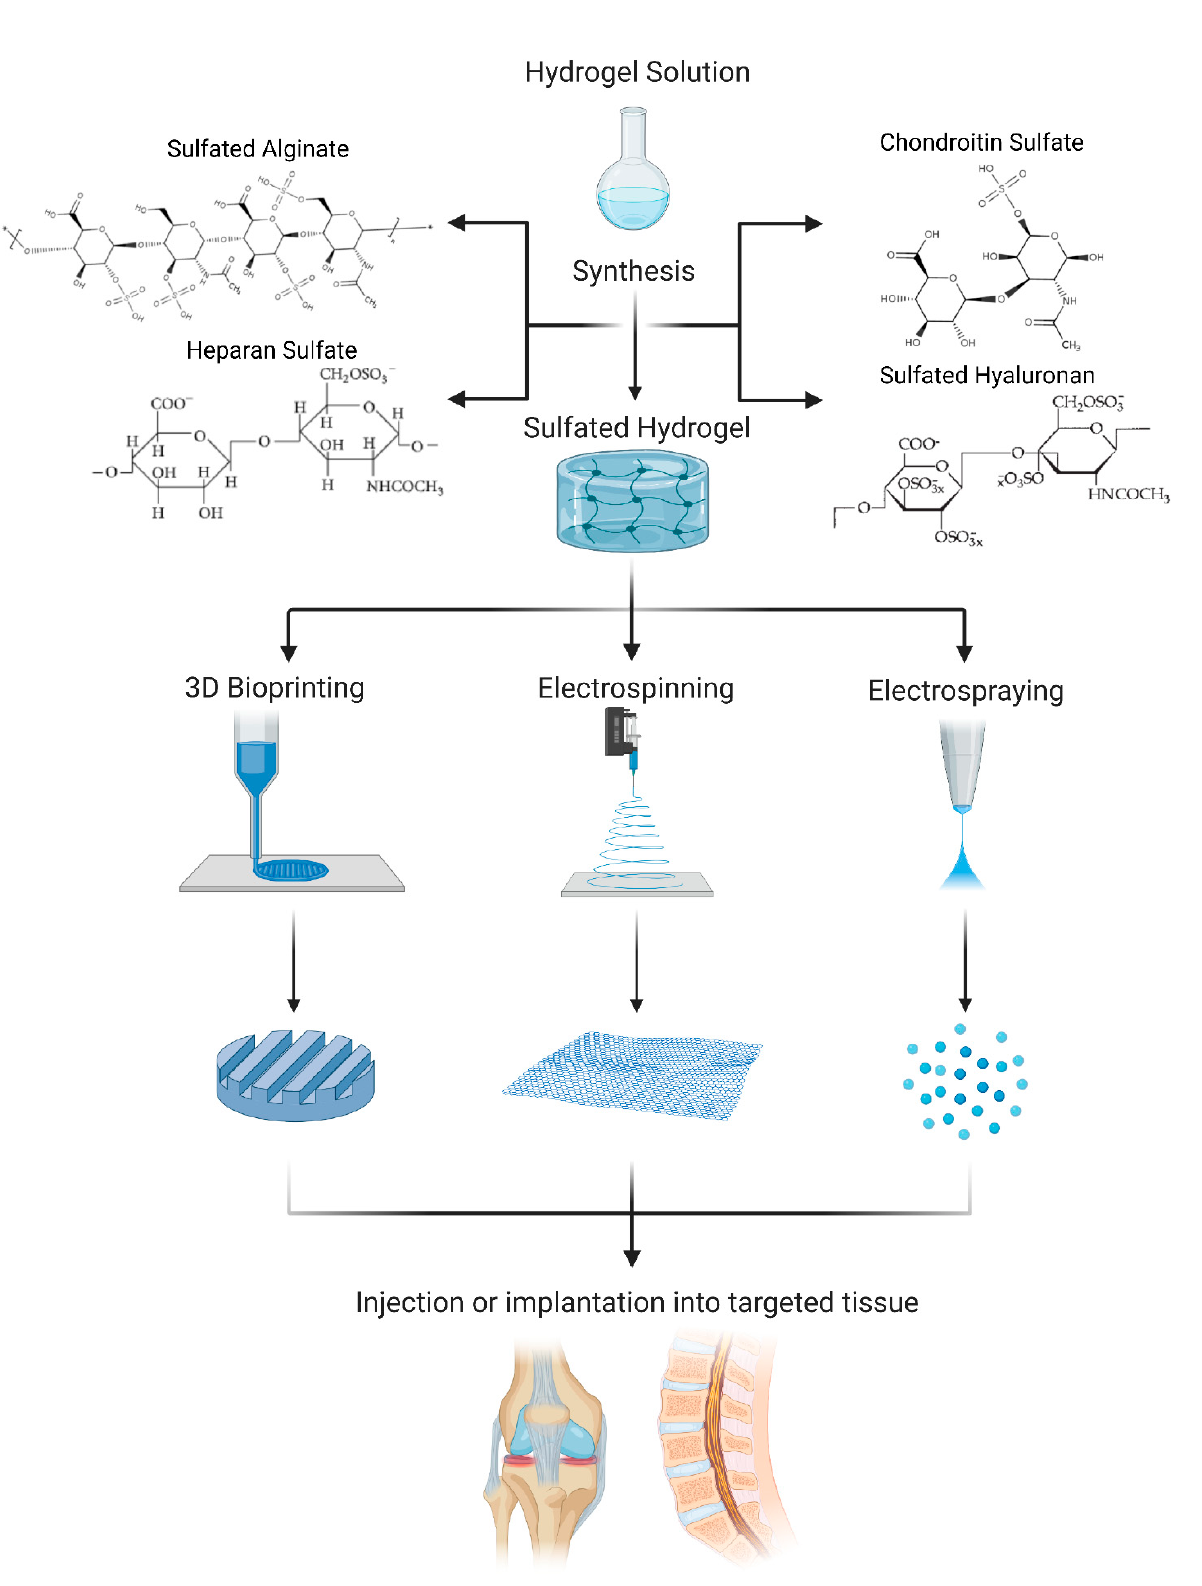
Figure 1. Schematic of the biofabrication process of sulfated hydrogels.